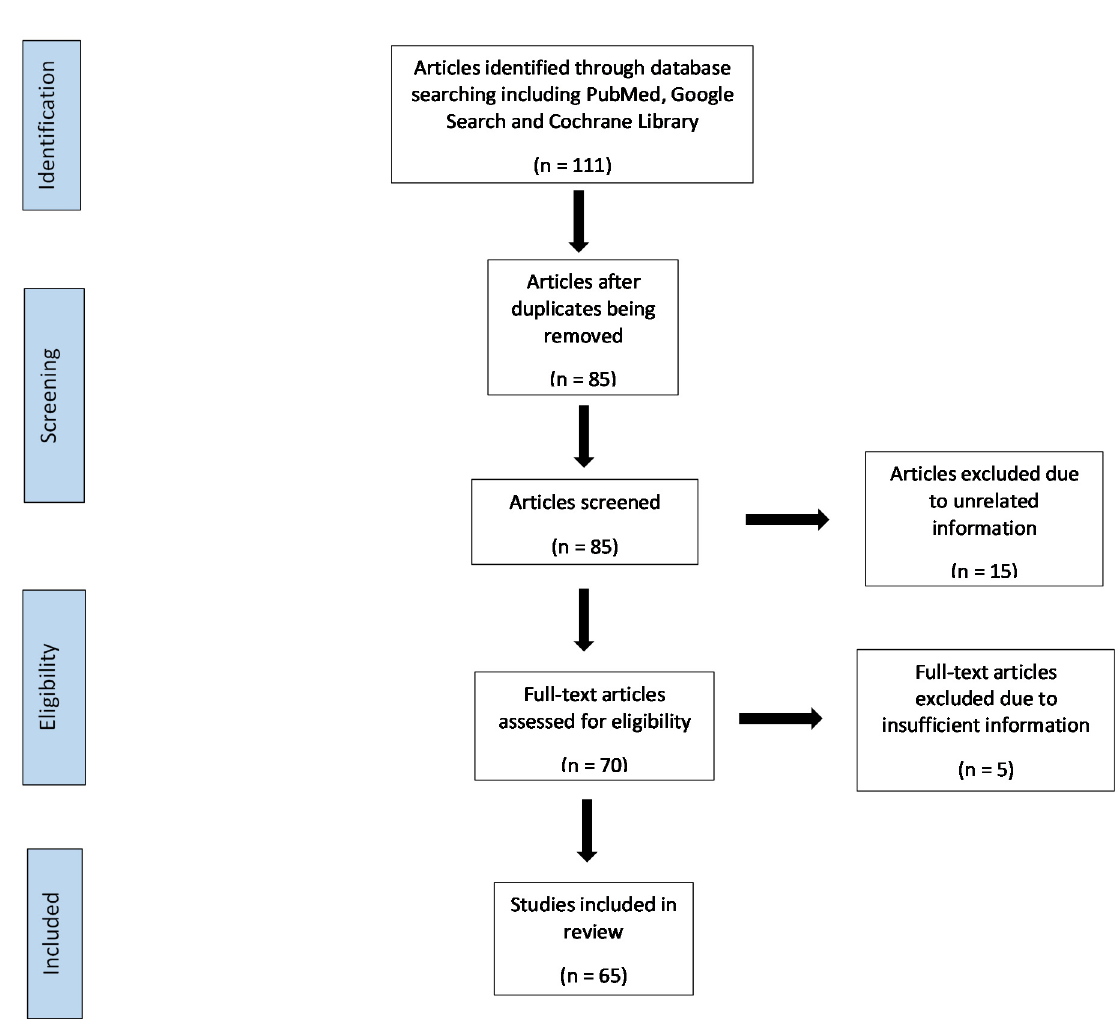
Figure 1. Flow diagram showing the article selection process.